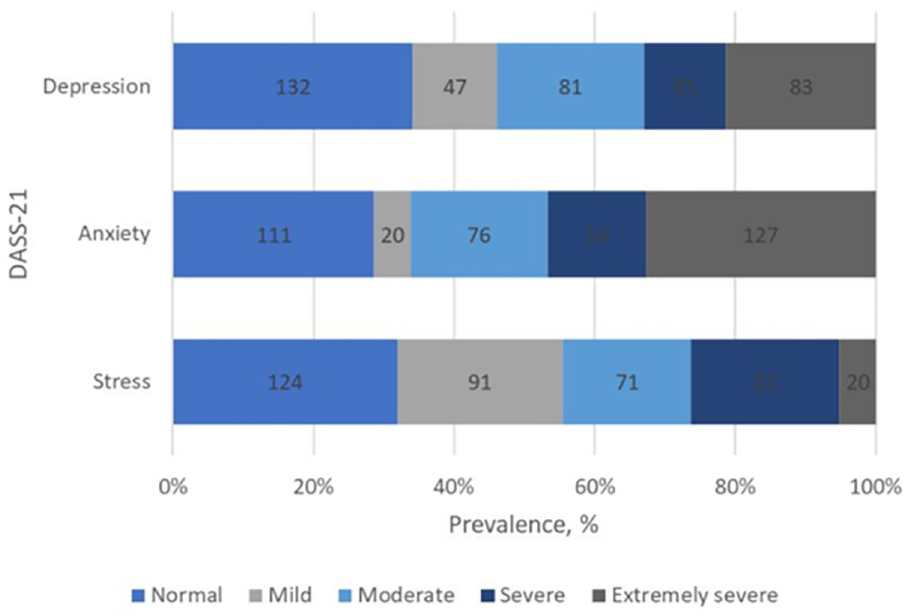
Fig 1. Prevalence of depression, anxiety and stress among university students studying in